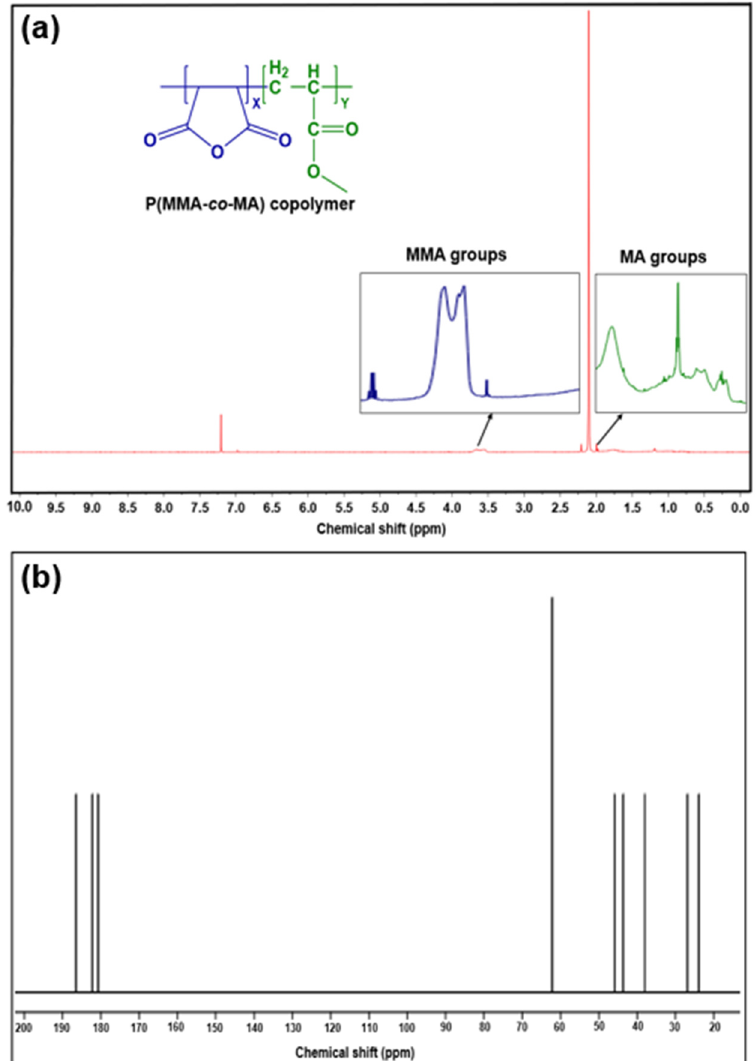
Figure 3. ( a ) 1 H-NMR spectrum; ( b ) 13 C-NMR spectrum of the P(MMA- co -MA) copolymer.